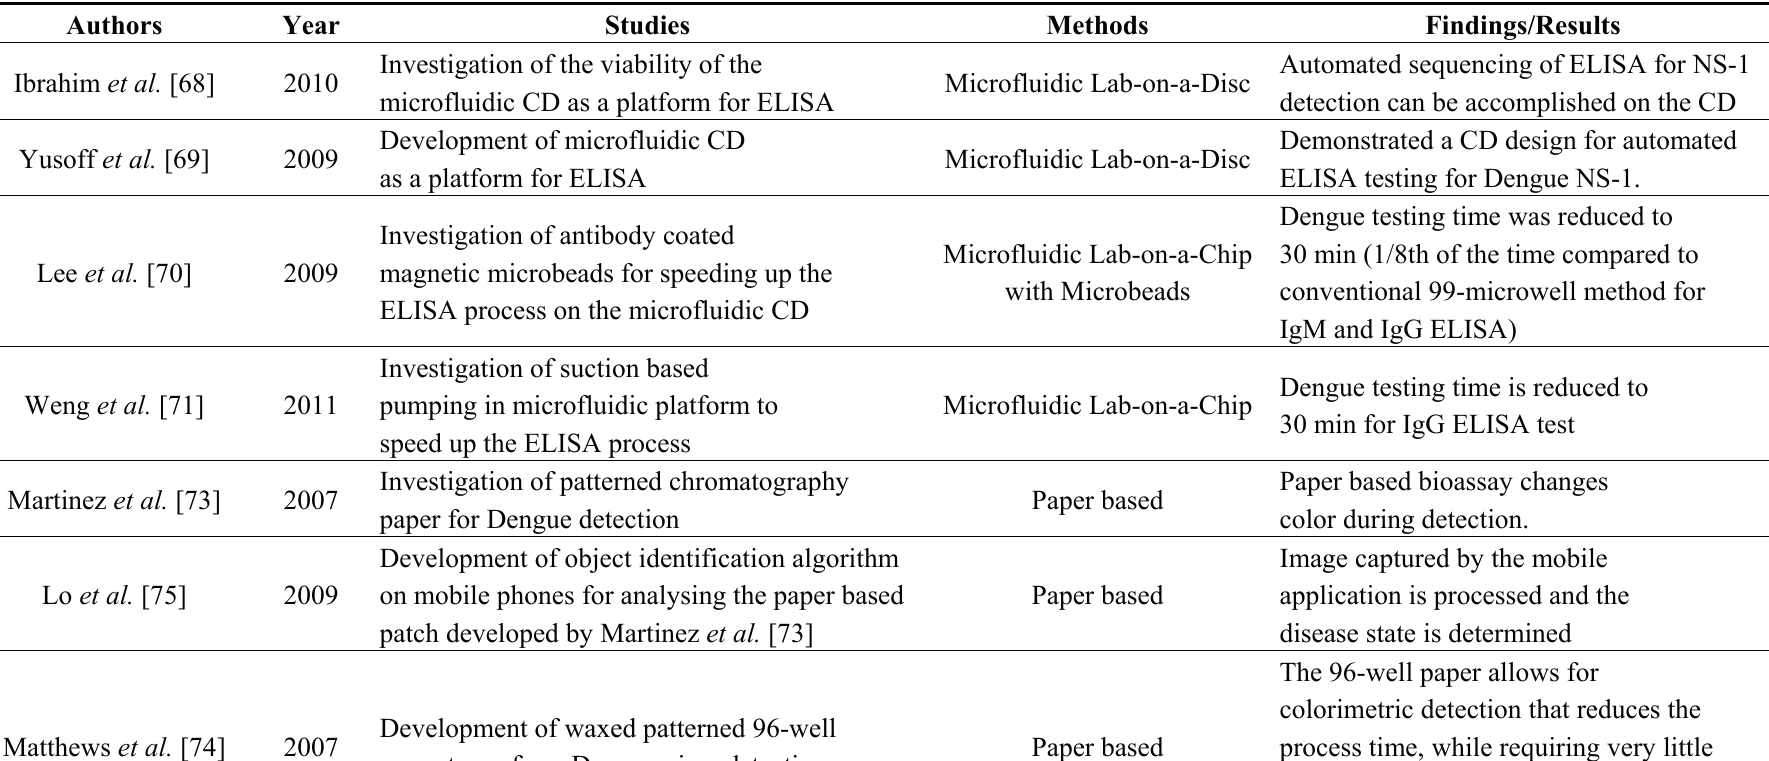
Table 4. Summary of biomedical engineering techniques of microfluidic lab-on-a-disc (LOD), lab-on-a-chip (LOC), and paper-based platforms in dengue